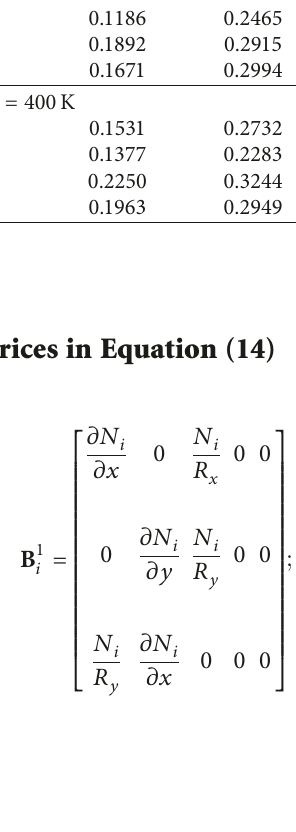
400K of O-type (cid:31) ∗ Temperature T (cid:31) 300K